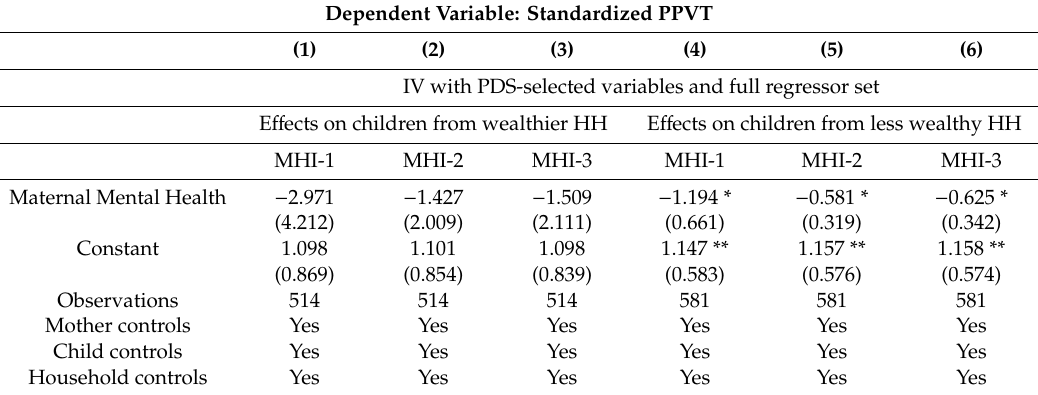
Table 5. Heterogeneous e ff ects of Maternal Mental Health on Children Vocabulary at Age 5 by HH Wealth Level.